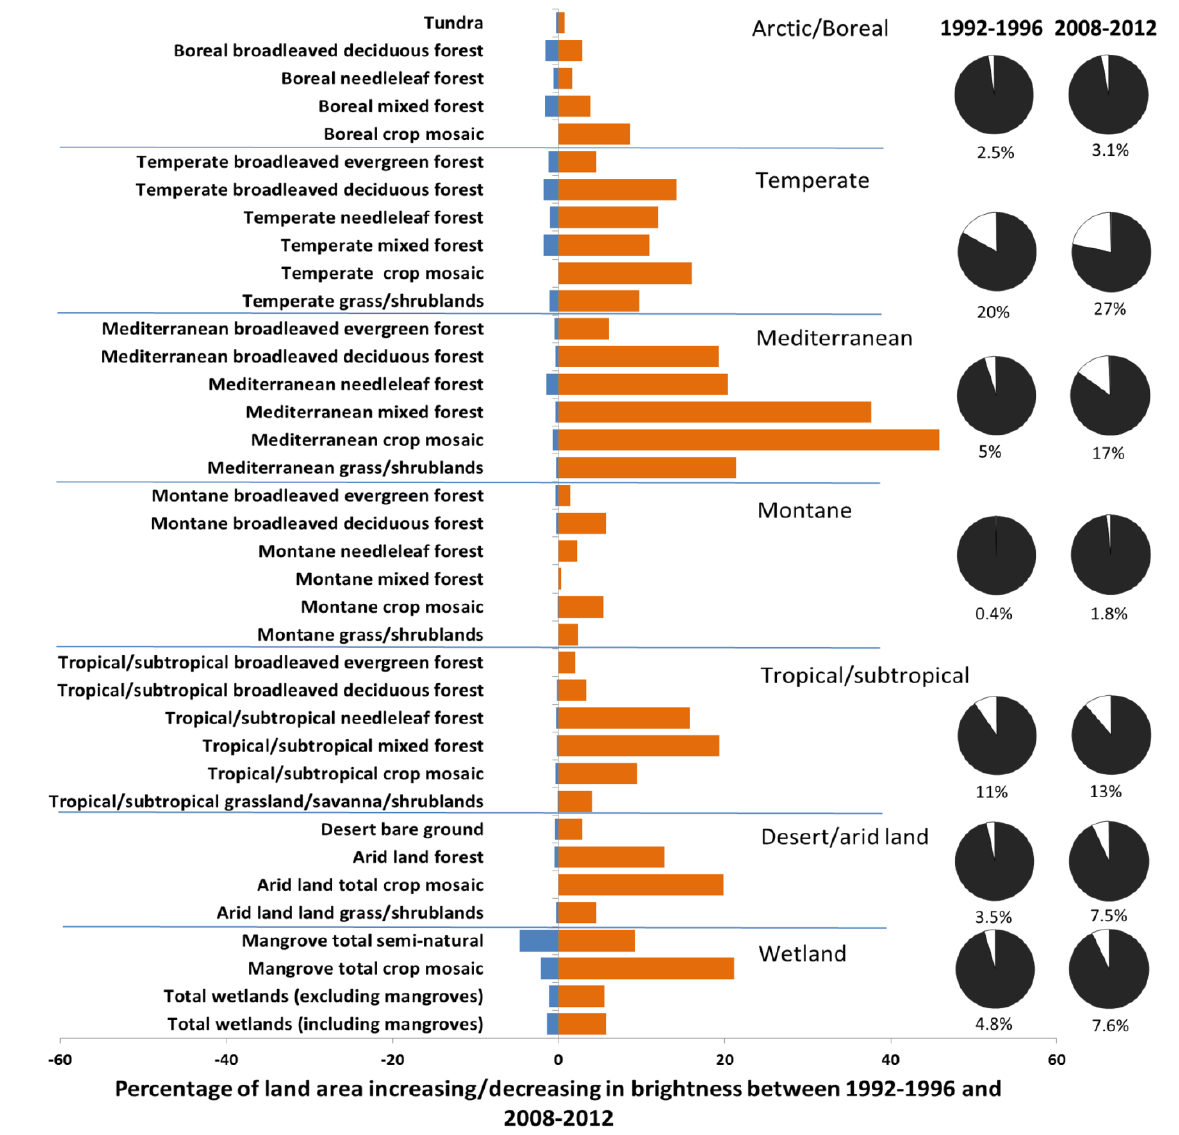
Figure 2. Horizontal bars show the percentage of total land surface area occupied by each ecosystem type for which artificial light was detected to increase (orange) and decrease (blue) by more than 3 Digital Number (DN) units between the time periods 1992–1996 and 2008–2012. Pie charts show the proportion of the natural ecosystems within each biome that had a brightness of 6 DN or